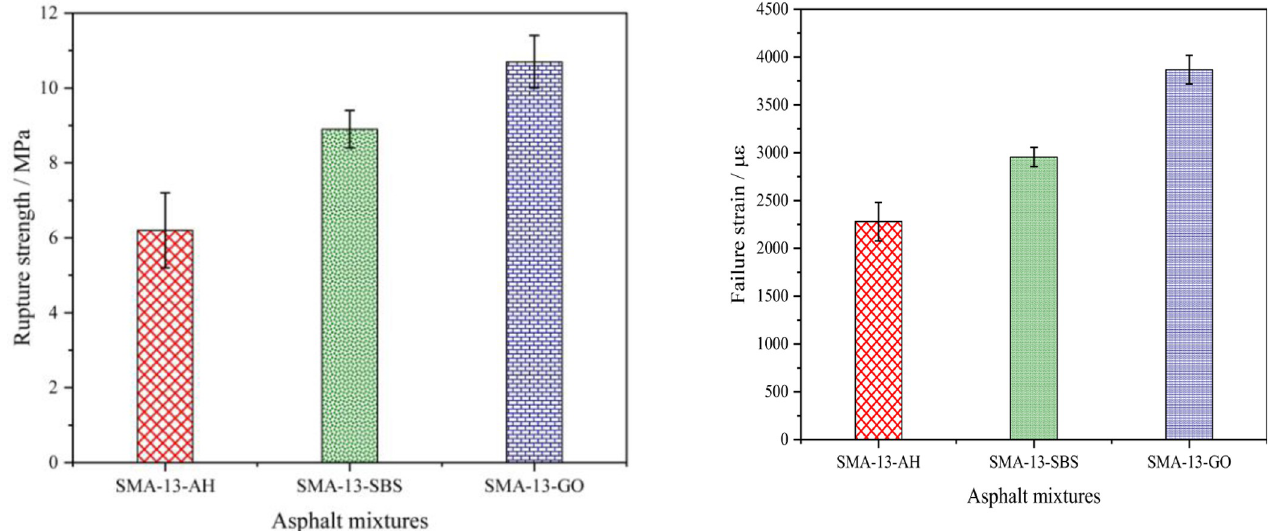
Fig 6. The asphalt mixtures’ low temperature performance. (a) Rupture strength. (b) Failure strain.